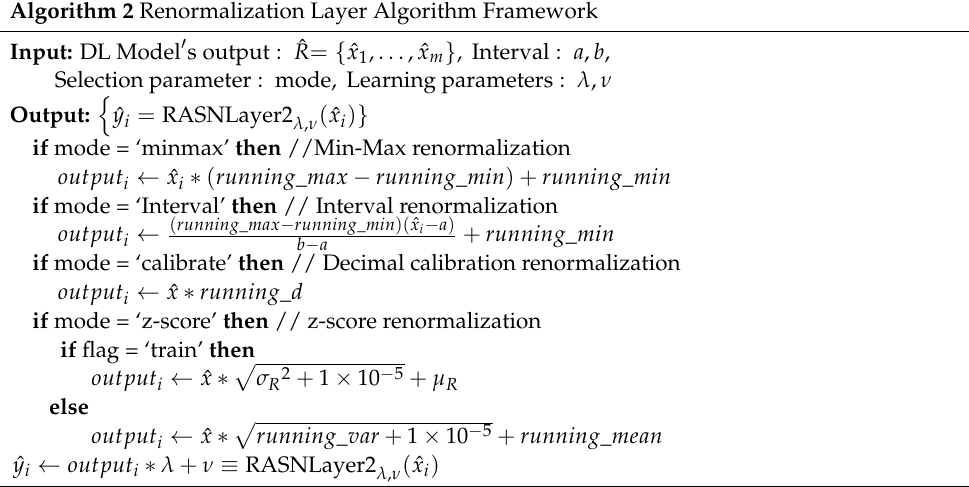
Algorithm 2 Renormalization Layer Algorithm